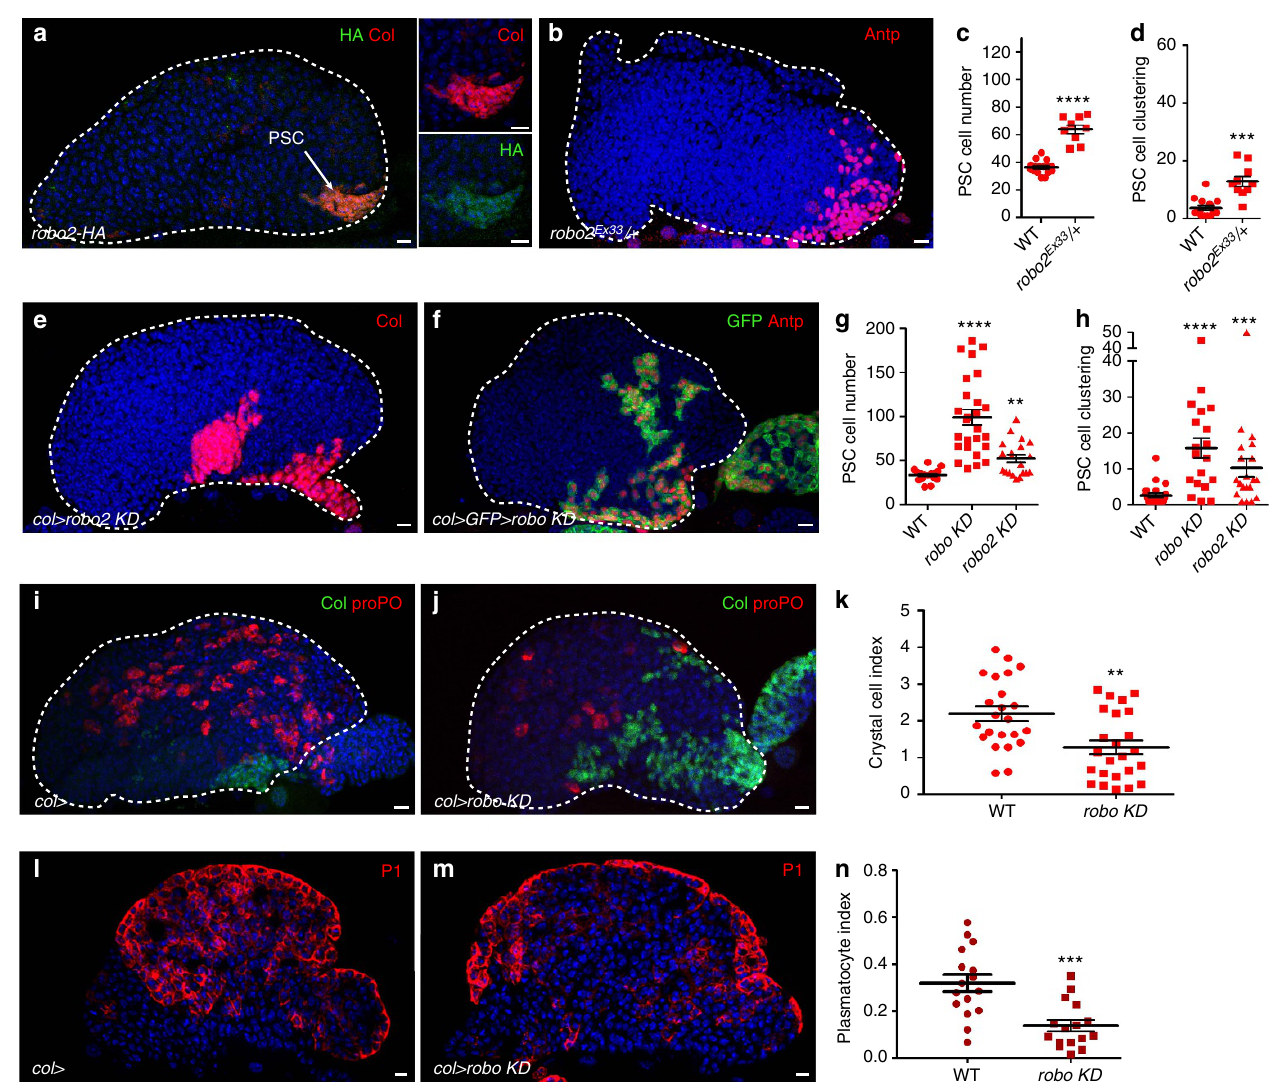
Figure 1 | Robo2 receptor is expressed in PSC cells and Robo signalling controls PSC cell number, clustering and function. ( a ) Robo2-HA (HA, green) in the LG is expressed in PSC cells marked by Col (red). Smaller panels provide enlarged views showing co-localization of Col with Robo2-HA. ( b ) robo2 Ex33 / þ heterozygous mutant LGs display a larger and disrupted PSC as stained by Antennapedia (Antp, red). ( e , f ) PSC cells are stained by Collier (col, red, e ) or Antp (red, f ) or express mcd8-GFP (col 4 GFP, green, f ). Reducing robo2 ( robo2 KD ) ( e ) or robo1, 2 and 3 simultaneously ( robo KD ) ( f ) in the PSC leads to an increased number of PSC cells and their deficient clustering. ( c , g ) Quantification of PSC cell numbers. ( d , h ) Quantification of PSC cell clustering. ( i , j ) WT ( i ) and robo KD ( j ) LGs stained for PSC cells (Col, green) and crystal cells (proPO, red). Compared with WT LGs, ( i ) fewer crystal cells differentiate in robo KD lymph glands ( j ). ( k ) Crystal cell index. ( l , m ) A confocal section in the middle of the LG of WT ( l ) and robo KD ( m ) LGs stained for ( n ) Plasmatocyte index. Statistical analysis t -test (Mann–Whitney nonparametric test) was performed using GraphPad Prism 5 software. For all quantifications and in all figures: error bars represent s.e.m. and * P o 0.1; ** P o 0.01; *** P o 0.001; **** P o 0.0001 and NS (not significant). In all figures nuclei are labelled with Topro or 4,6-diamidino-2-phenylindole (blue). Scale bars, 10 m Slit from the cardiac tube controls PSC morphology . Slit is the canonical ligand of Drosophila Robos. High levels of Slit were detected in the CT and low levels in PSC cells (Fig. 3a,b). and are not de novo respecified MZ cells, we turned to lineage Expression of slit dsRNA in the CT using the hand D -Gal4 driver, tracing to mark all cells issued from the MZ, using the Gal4 resulted in barely detectable Slit levels in both the CT and the LG technique for real-time and clonal expression (G-TRACE) method (Supplementary Fig. 4c–d), indicating that the source of Slit is the with the dome-Gal4 MZ-specific driver 2,35 . We found no PSC cells, CT and that Slit in the PSC has diffused from the CT. In support as labelled by Antp, expressing GFP in either WT or robo2 mutants of this conclusion, reducing slit expression ( col 4 slit KD ) in (Fig. 2k–n). This established that the scattered PSC cells observed PSC cells (Supplementary Fig. 4g–h) had no effect on PSC in robo2 mutant LGs all originate from the PSC lineage. morphology, while reduction of slit expression specifically in Altogether, these data indicate that during larval development the CT using either hand D -gal4 or another CT driver robo KD PSC cells concomitantly over-proliferate and disperse. NP1029-gal4 (ref. 36), led to both increased number and defective